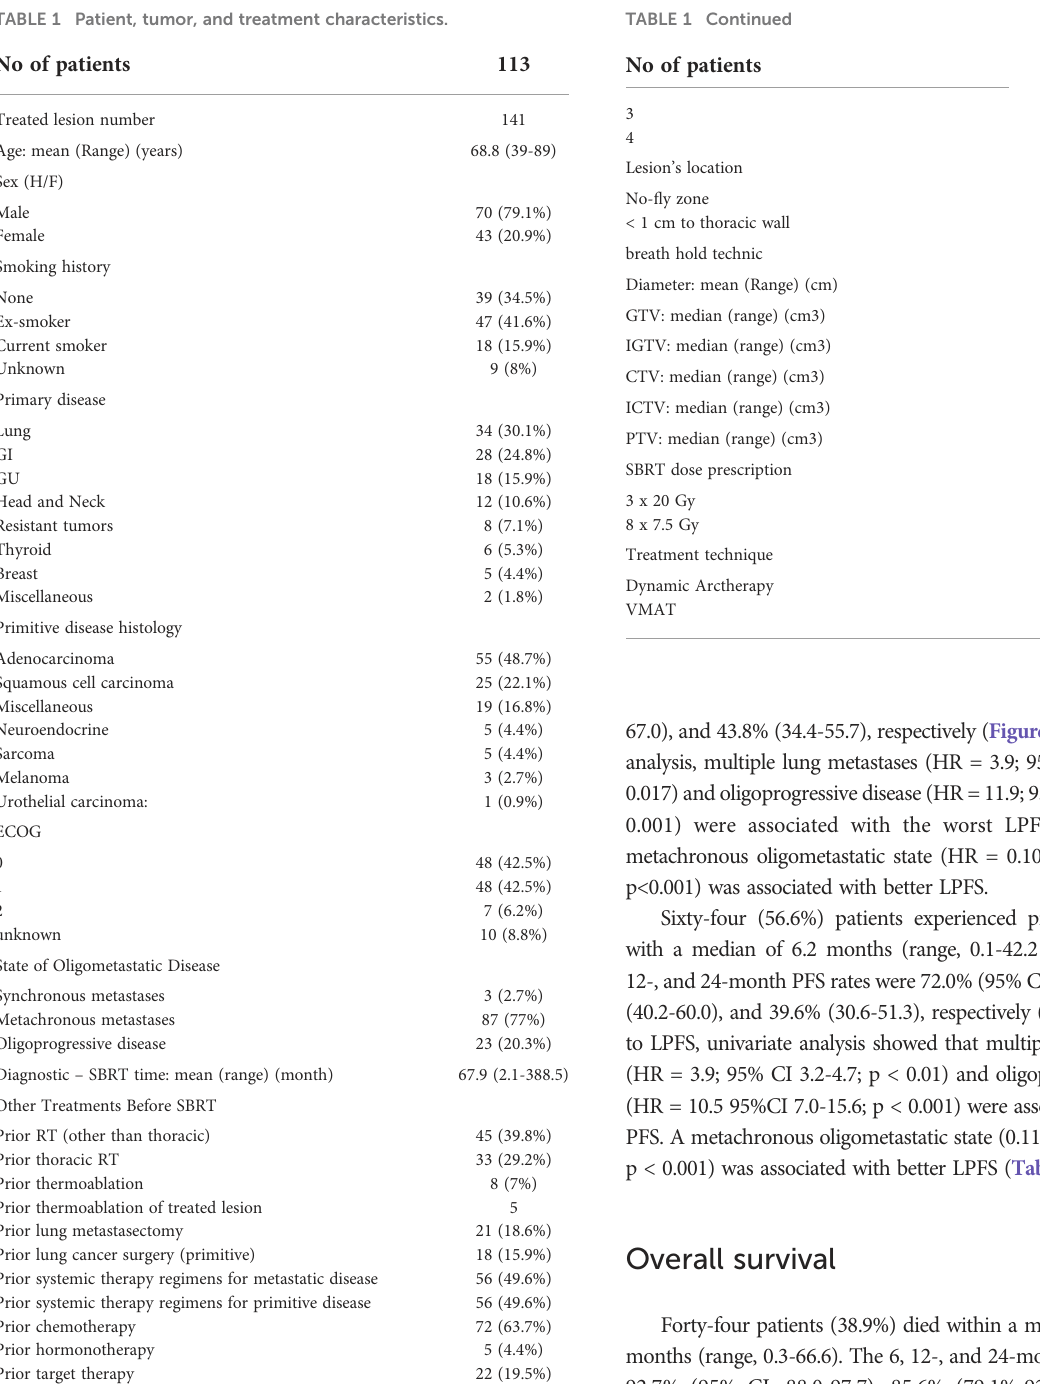
Forty-four patients (38.9%) died within a median time of 16.6 months (range, 0.3-66.6). The 6, 12-, and 24-month OS rates were 92.7% (95% CI: 88.0-97.7), 85.6% (79.1%-92.7%), and 69.7% (60.7%-80.0%), respectively ( Figure 1 ). According to the univariate analysis, an ECOG greater than 0 was the only prognostic factor for OS. The 6, 12-, and 24-month OS rates for patients with ECOG 0 were 97.9% (95% CI: 94.0-100.0), 92.6% (84.9%-100.0%) and 83.6% (72.3%-96.7%), respectively compared to 87.1% (95% CI: 78.6-96.5), 77.2% (66.6%-89.5%) and 59.9% (47.1%-76.3%) respectively for patients with ECOG >0 (HR = 3.5; 95% CI 3.2-3.8; p < 0.01) ( Table 2 ).